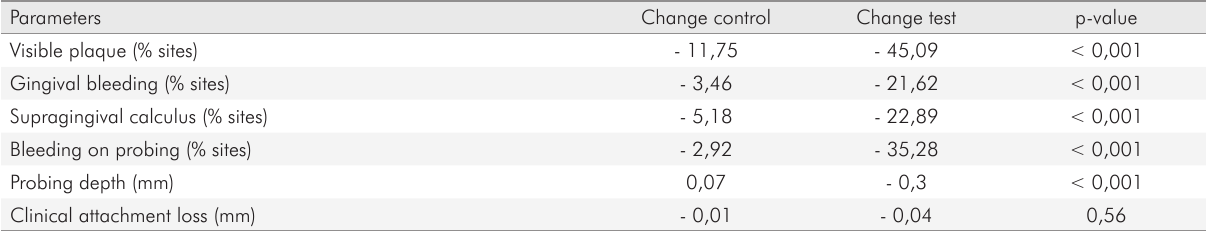
Table 2. Change in periodontal characteristics of control and test groups between baseline and final measurements.